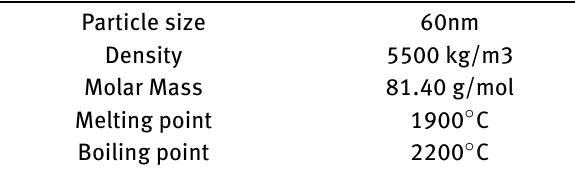
Table 1: Physical and chemical properties of